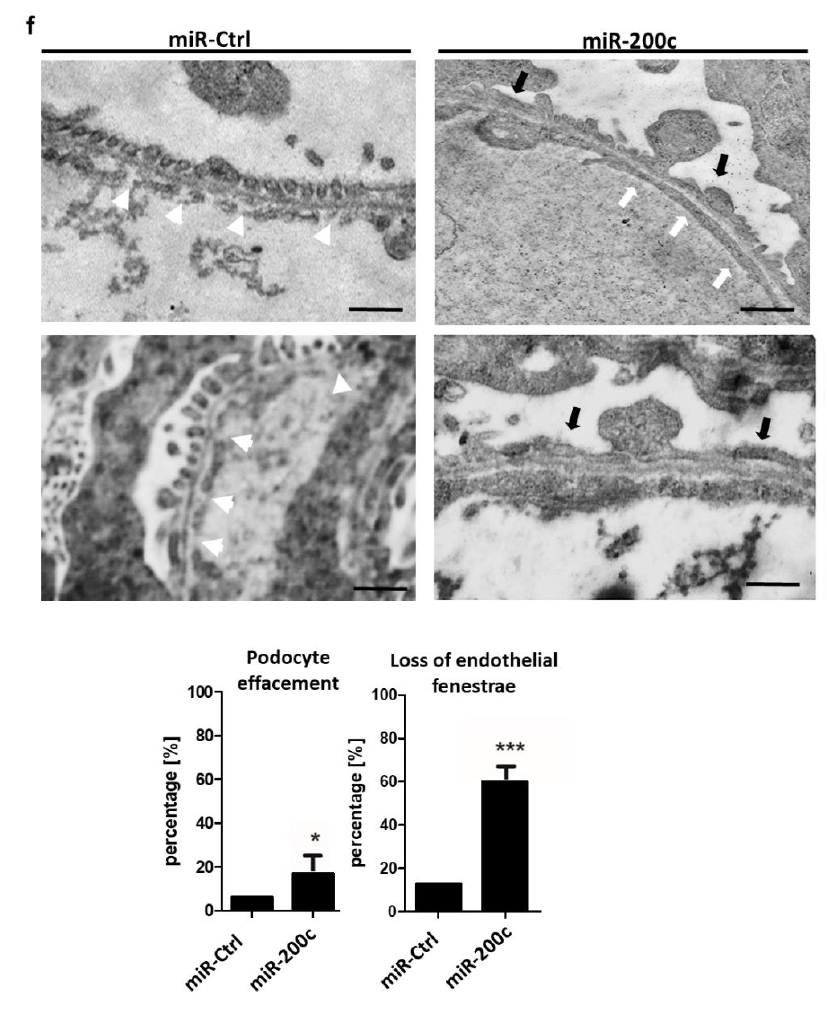
Figure 2. miR-200c mimic induces edema, proteinuria, podocyte effacement and loss of endothelial fenestrations. Zebrafish were injected with an miR-Ctrl mimic and miR-200c-3p mimic at the one- to-four cell stage. ( a ) Phenotype pictures of zebrafish larvae at 96 h postfertilization (hpf). Scale bar = 500 µ m. ( b ) Staining the zebrafish pronephroi with hematoxylin–eosin (H&E) at 96 hpf after miR-Ctrl and miR-200c mimic injection in egg stage. Scale bar = 100 µ m and 10 µ m in the zoom in ( c ) Quantification of phenotype by severity of pericardial and yolk sac edema in percentage. Examples of phenotypic changes, grading the normal zebrafish phenotype with no edema P1 and the most “edematous” phenotype with P4 at 96 hpf. ( d ) Timely fusion of the glomeruli at 48 hpf after miR-200c overexpression in Tg (wt1b:EGFP) zebrafish, which express eGFP under the control of the wt1b promotor. Scale bar = 200 µ m. ( e ) Representative images of an eye of Tg(I-fabp:VDBP:EGFP) fish, which were injected with an miR-Ctrl or miR-200c mimic. Scale bar = 150 µm. Quantification of loss of circulating high-molecular-weight proteins by measuring max. eye fluorescence in the retinal vessel plexus of Tg(l-fabp:VDBP:EGFP) zebrafish larvae at 96 hpf. *** p < 0.001. ( f ) Top: TEM pictures of the zebrafish GFB at 96 hpf after miR-200c mimic and miR-Ctrl injection in egg stage. White arrows show fenestration in the control zebrafish, which are lost in miR-200c-injected zebrafish. Black arrows show podocyte effacement. Scale bar = 500 nm. Bottom: quantification of loss of endothelial fenestrae and podocyte effacement in percentage of representative fish in each group. * p < 0.05 ; *** p < 0.001. 2.3. miR-200c Is Induced due to Cell Stress in Glomerular Endothelial Cells As we observed that miR-200c overexpression caused phenotypic changes in podocytes and glomerular endothelial cells in the zebrafish model, we further investigated in which of the two cell types miR-200c expression is induced. The miR screening provided